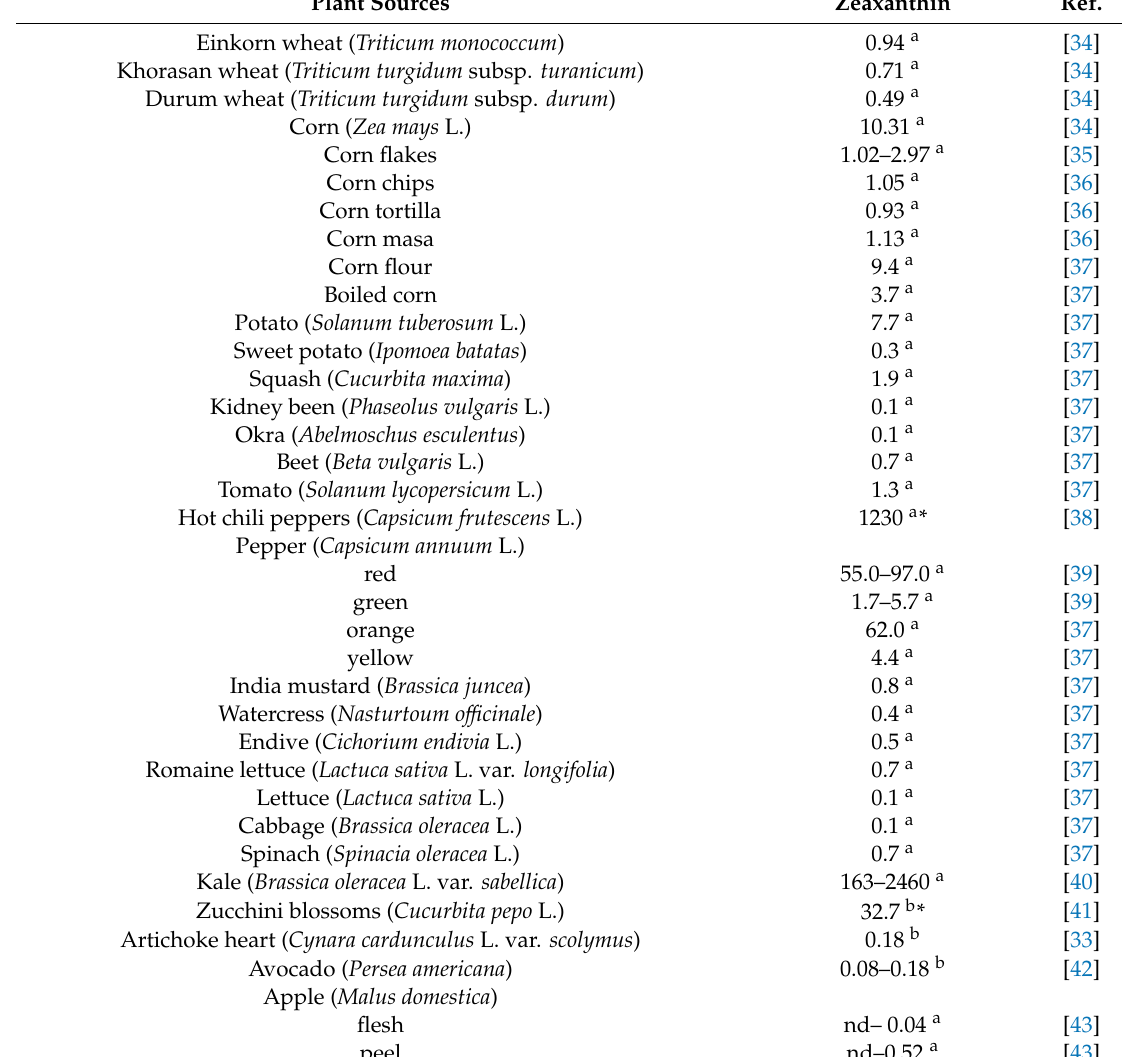
Table 1. Dietary sources of zeaxanthin ( µ g / g dry weight a or µ g / g fresh weight b ). Plant